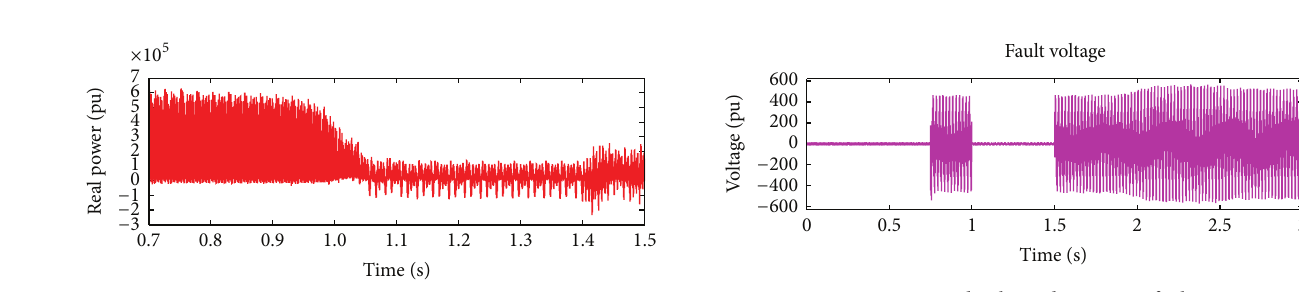
Figure 8: Load voltage during L-G fault.